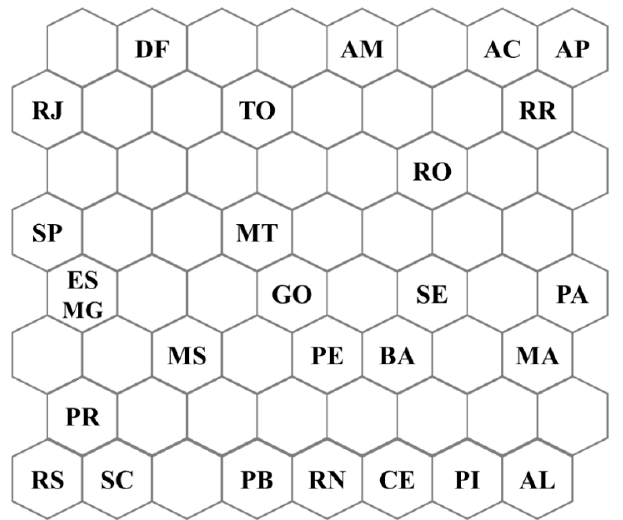
Figure 2. Distribution of Brazilian federative units according to the winning neuron. Where: Acre—